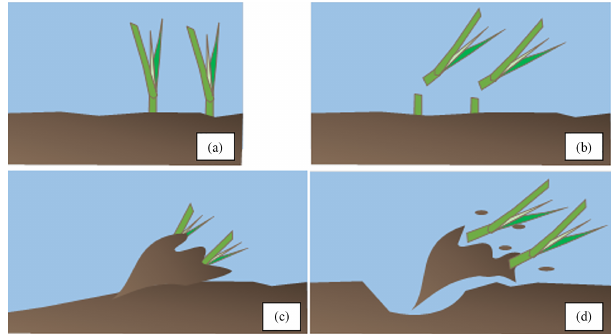
Figure 8. (a) Eelgrass and its damage pattern: (b) cut-off, (c) sand deposition and (d)